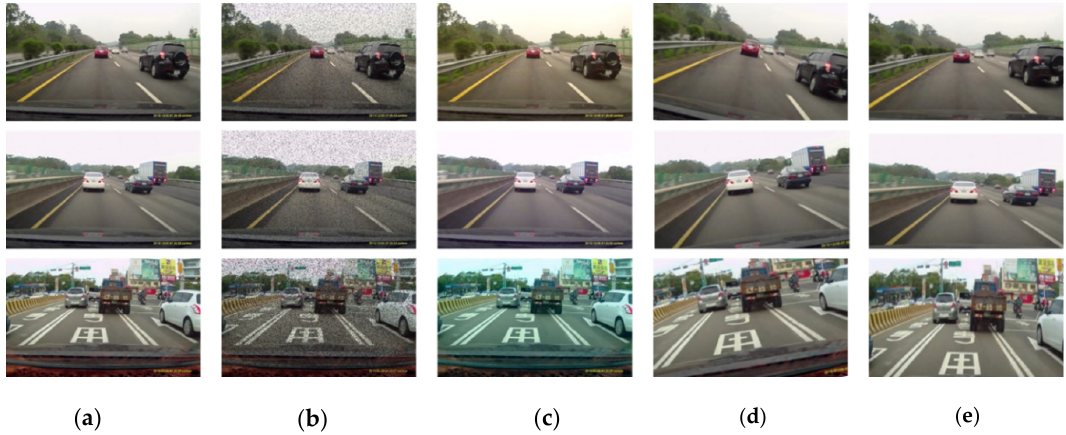
Figure 6. Examples of augmented data. ( a ) Original images, ( b ) dropout, ( c ) color transformation, ( d ) rotation, ( e ) cropping.